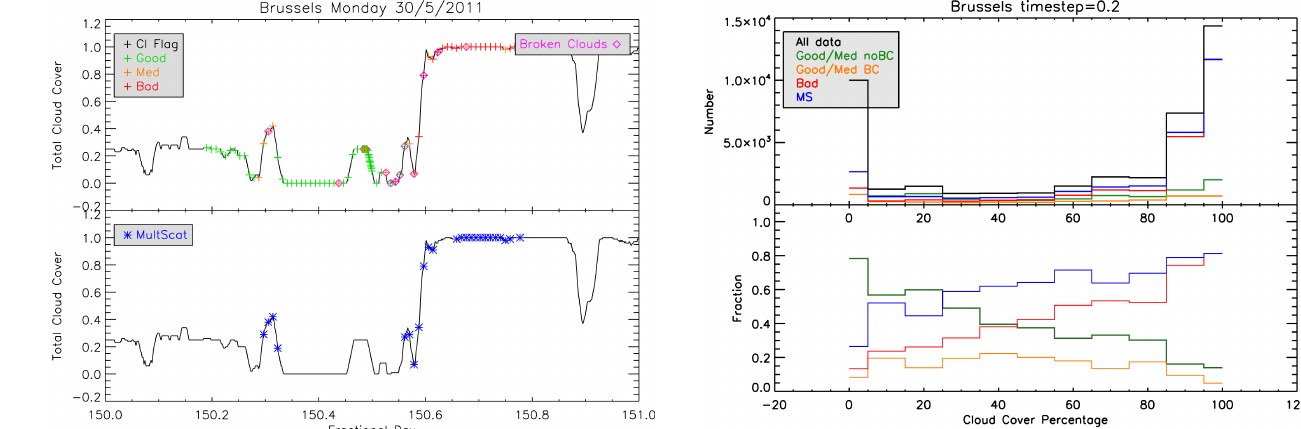
Figure 10. Total cloud-cover values from thermal infrared mea- surements are given in black points. Top: overplotted in coloured crosses are the respective CI-flag values as derived from our cloud- screening method (green/orange/red = good/med/bad). Data with a broken-cloud flag are marked with a magenta diamond. Bottom: in blue asterisks we plot data points with a multiple-scattering flag.